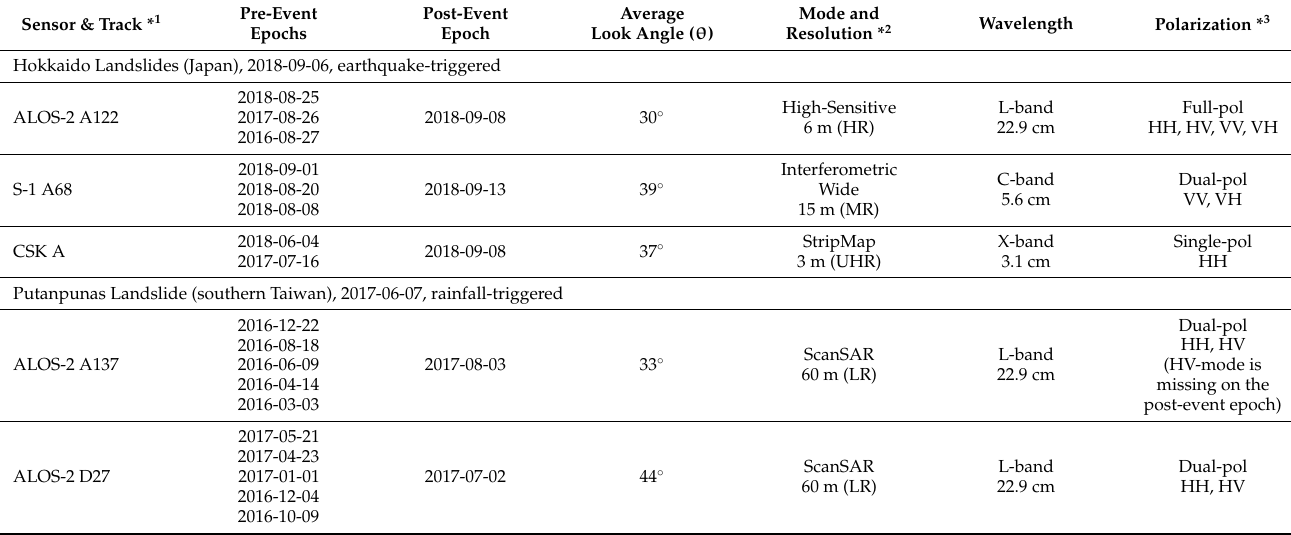
Table 1. List of SAR data used in this